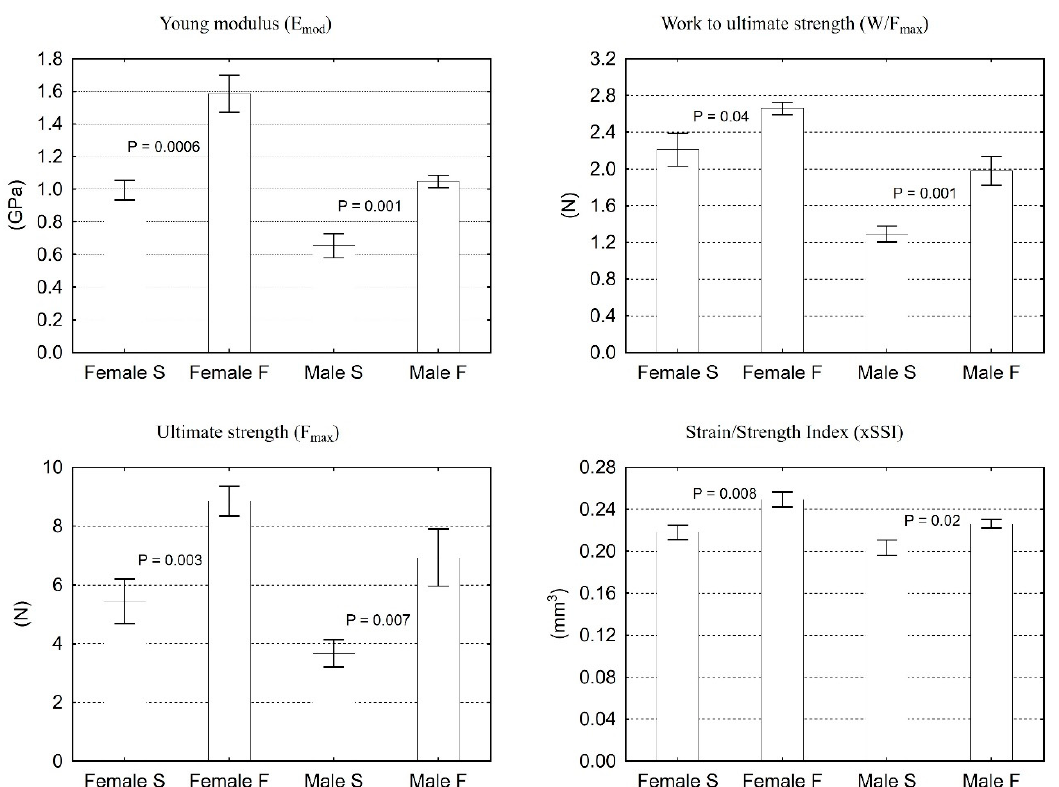
Figure 2. Mechanical parameters of isolated tibia established using three-point bending test and pQCT of female and male rats on the weaning day. Results are the means ± S.E.M. ( n = 8). Statistically significant differences between S and F groups were established by the t -Student ( p < 0.05).